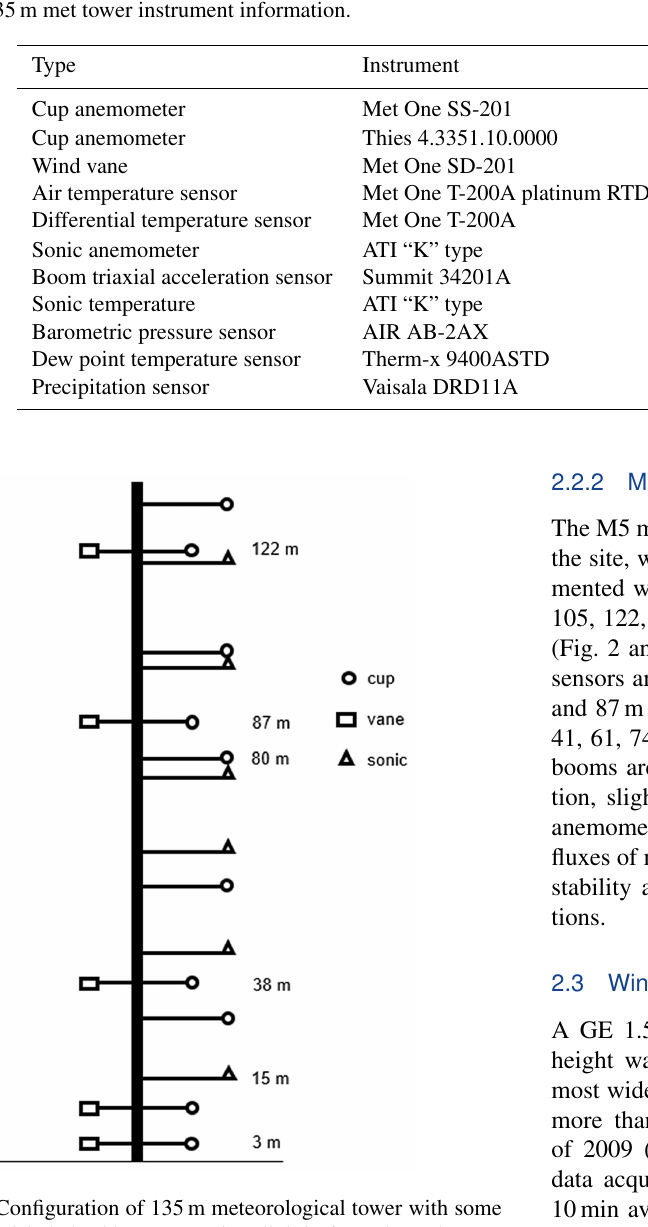
Figure 2. Configuration of 135m meteorological tower with some key heights labeled. This tower varies slightly from the M4 tower described in Clifton et al. (2013b), but data are available online (NWTC,